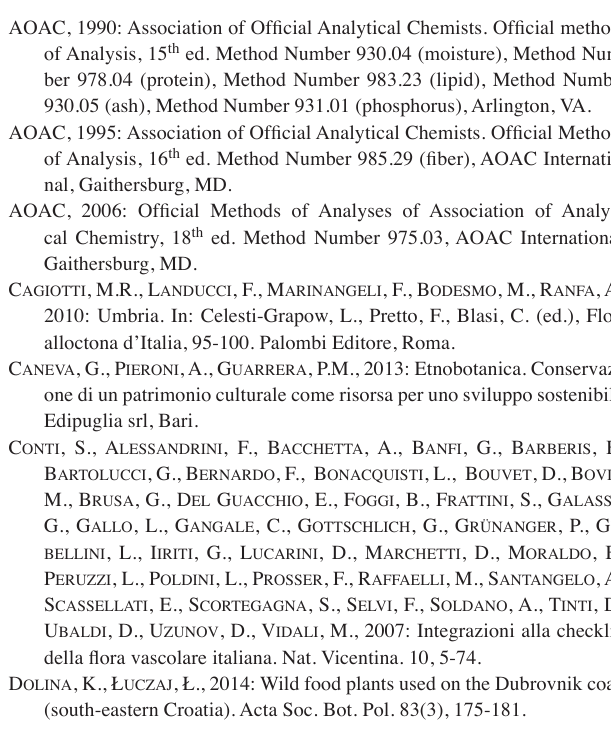
Tab. 1: Comparison of chemical composition and mineral content (mg/100 g of edible parts) values of T. apulum and U. dalechampii with those of other cultivated species T.